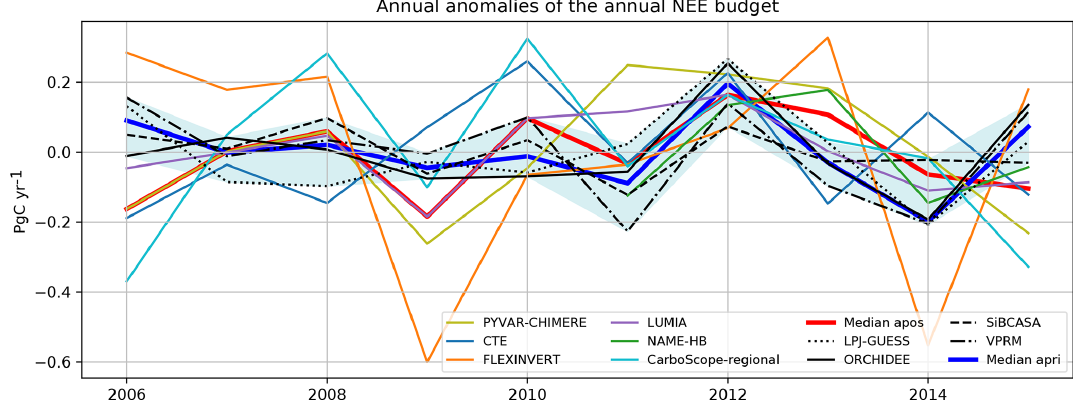
Figure 6. NEE anomalies of the six inversion posteriors and of the four priors. The median of the prior anomalies is shown as a thick blue solid line; that of the posteriors is shown as a thick red solid line. The blue shaded area shows the envelope of prior